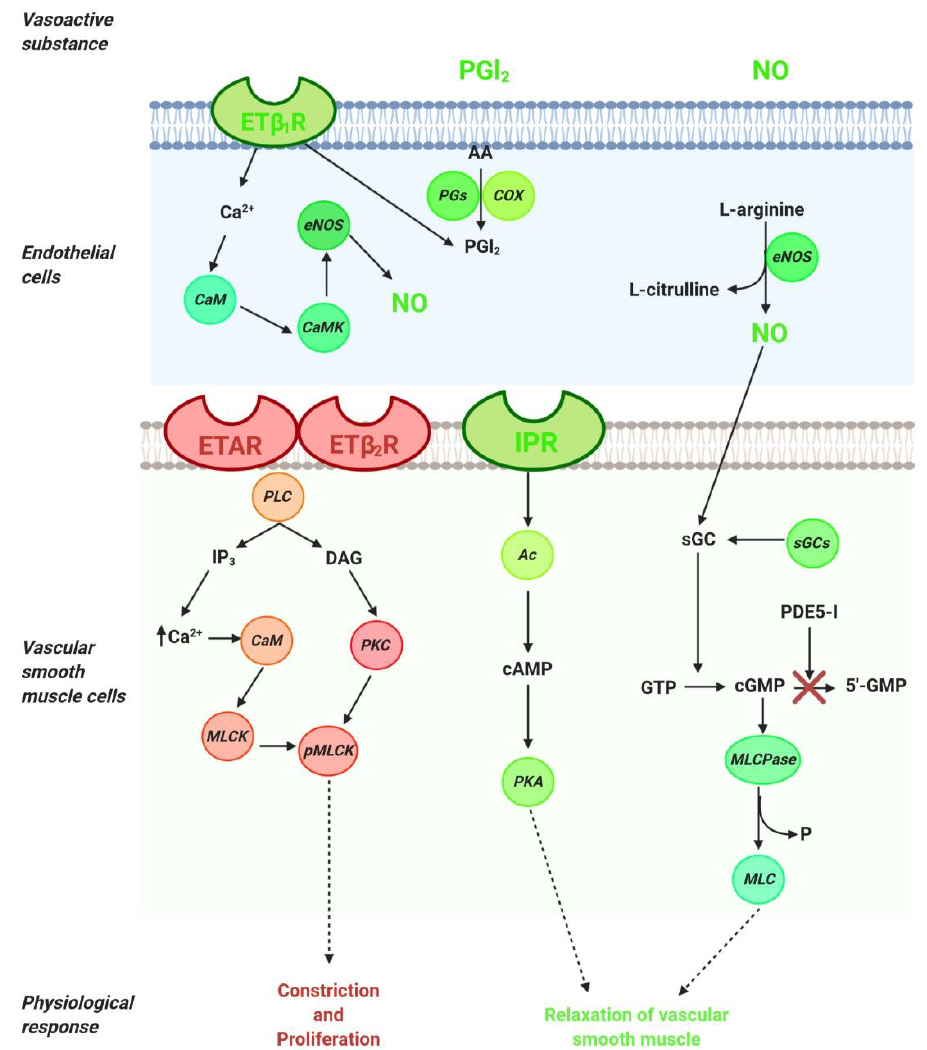
Figure 1. Signaling pathways in the regulation of pulmonary vascular tone. Arachidonic acid (AA); adenylyl cyclase (Ac); calmodulin (CaM); calmodulin kinase (CaMK);cyclooxygenase (COX); cyclic adenosine monophosphate (cAMP); cyclic guanosine monophosphate (cGMP); diacylglycerol (DAG); endothelial nitric oxide synthase (eNOS); endothelin 1 (ET-1); endothelin type A receptor